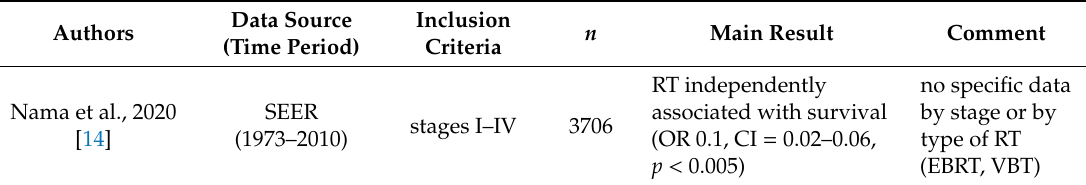
Table 1. Overview of studies of postoperative radiotherapy in uterine carcinosarcoma using data from the United States Surveillance, Epidemiology and End Results (SEER) database